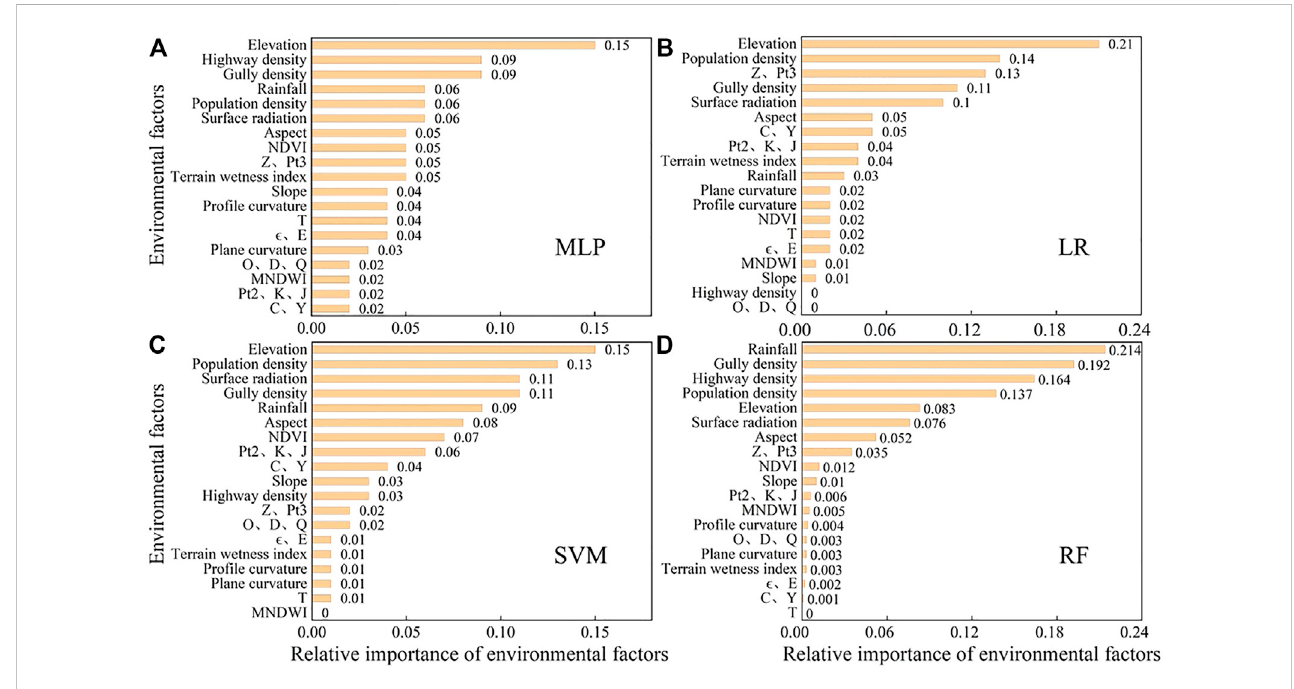
FIGURE 8 Importance ranking of environmental factors: (A) MLP, (B) LR, (C) SVM, (D) RF.